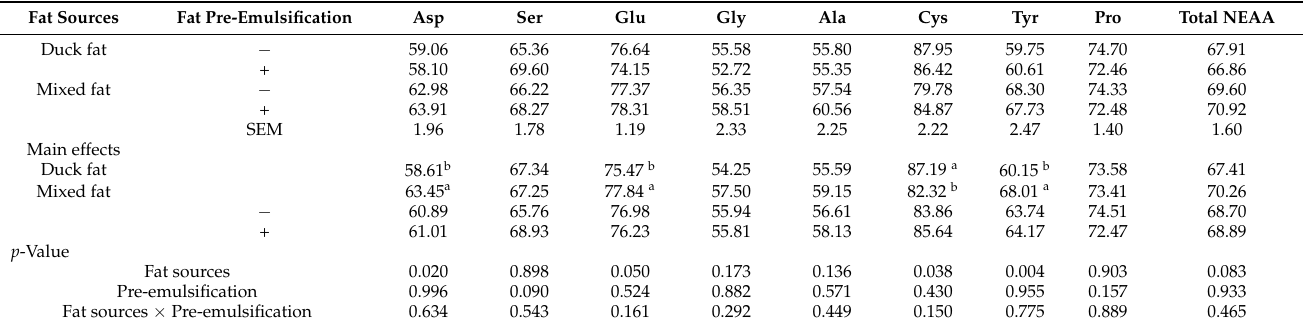
Table 7. Effects of fat sources and pre-emulsification on standardized ileal digestibility of nonessential amino acids of ducks at 40 days of age (%) 1,2